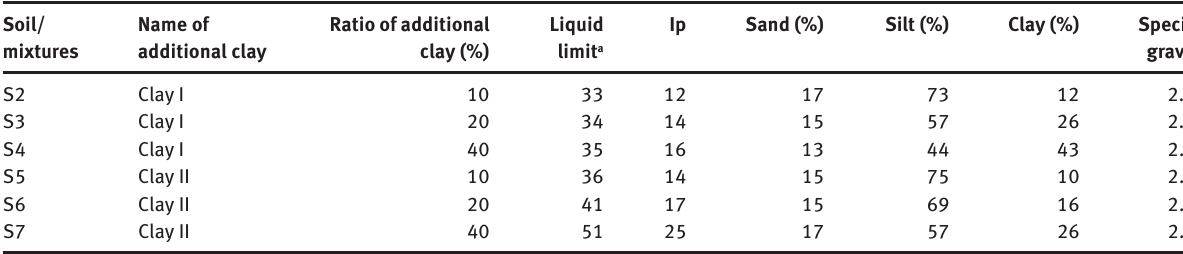
Table 2 Geotechnical index properties of artificially mixed soils. Soil/ mixtures